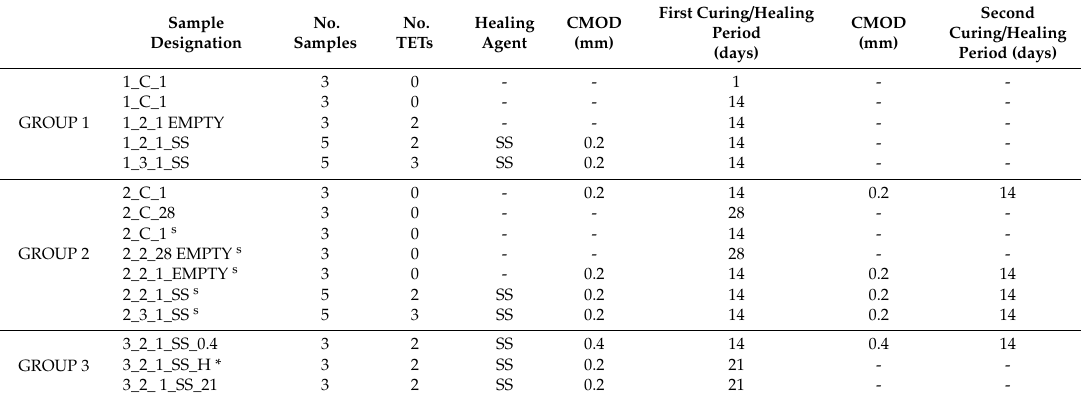
Table 2. Details of the experimental